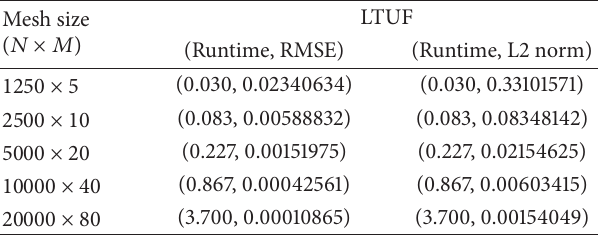
Table 4: Comparison of RMSE and L2 norm with LTUF method in the solution.